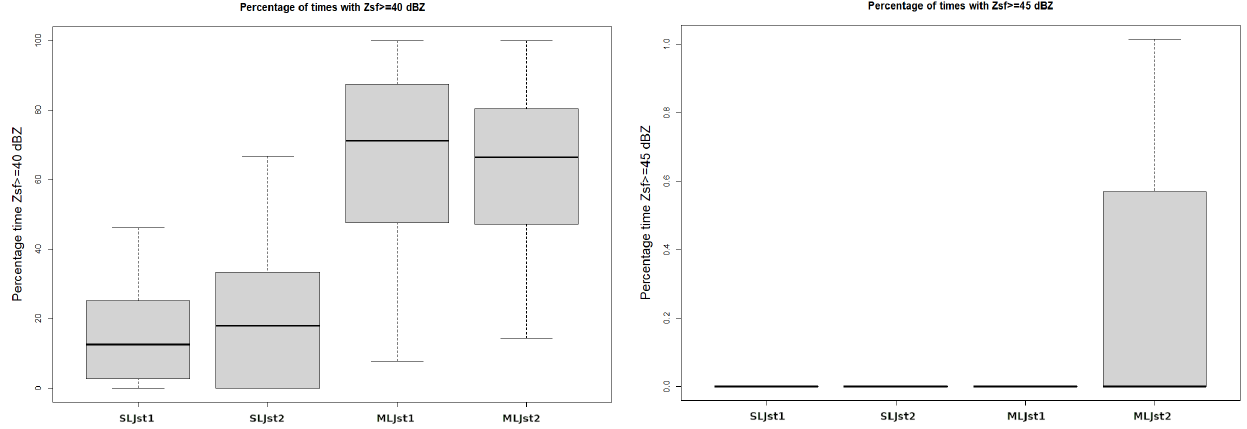
Figure 11. Same as Figure 10, but for the number of times that surface reflectivity exceeded a certain threshold: ( left ) 40 dBZ; ( right ) 45